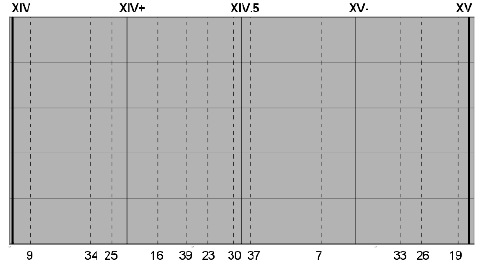
FIGURE 2 | Virtual frets (v.fs.; solid lines) and nodes of the string up to vibrational mode 39 (dashed lines) between frets XIV and XV. Above, in roman numerals: frets/v.fs. nomenclature; below, in Arabic numerals: number of the lowest v.m. at each